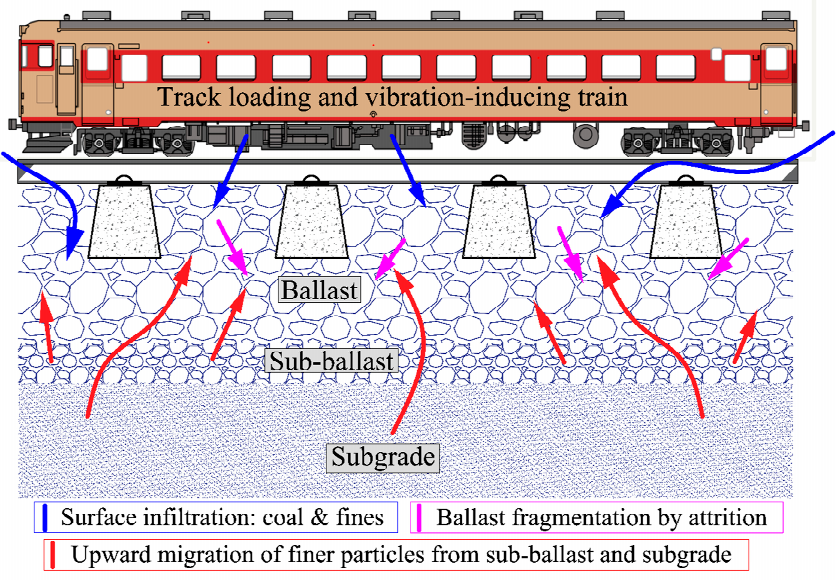
Figure 1. Ballast fouling mechanisms.